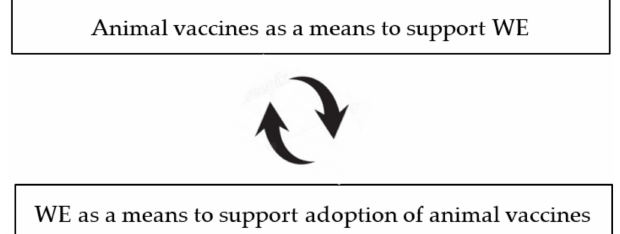
Figure 1. Conceptual association between WE and animal